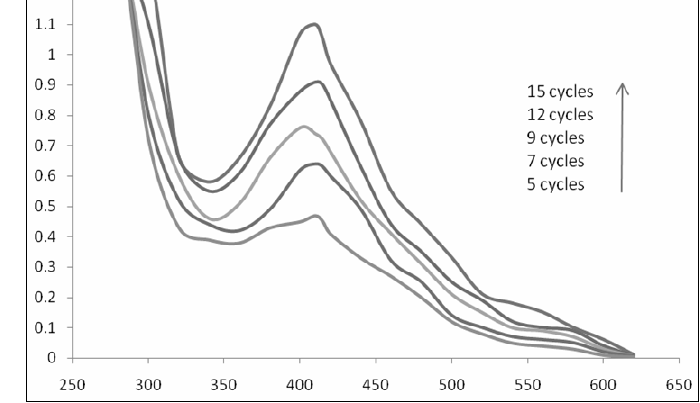
Figure 3. UV-Vis spectra recorded as a function of time of reaction of 1 mM aqueous solution of AgNO with Bacillus subtilis culture supernatant irradiated with microwave. The 3 irradiation period was 5 cycles up to 15 (microwave exposure was 15 s per